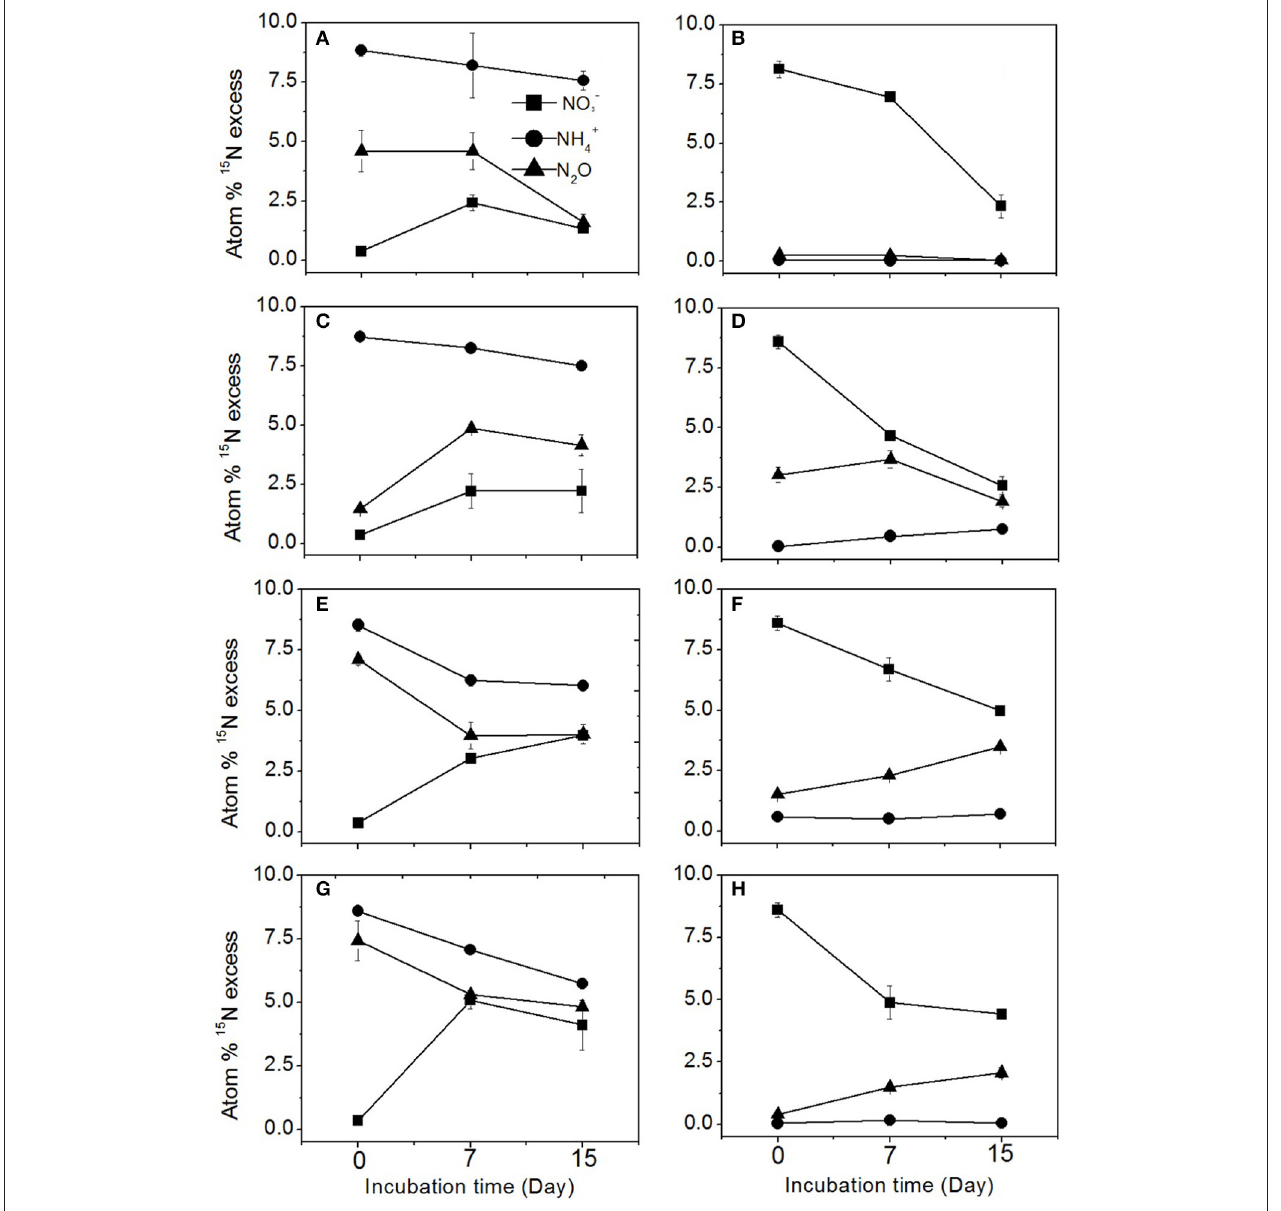
FIGURE 2 | 15 N enrichment of N 2 O, NH + 4 , and NO − 3 in the 15 N labeled NH + 4 and NO − 3 treatments during the incubation. (A,C,E,G) represent the 15 N-labeled NH + 4 treatment in the sugarcane, vegetable, dairy pasture, and cereal cropping soils, respectively. (B,D,F,H) represent the sugarcane, vegetable, dairy pasture, and cereal cropping soils, respectively. Error bars represent standard